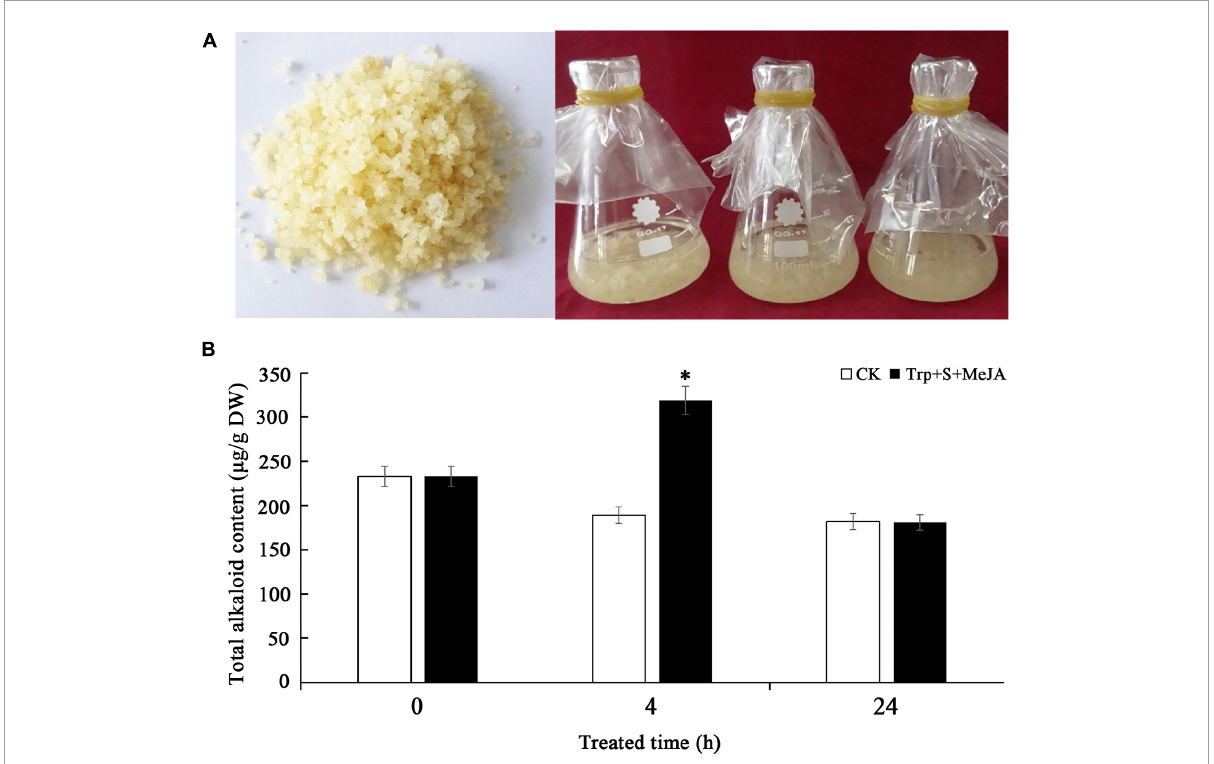
FIGURE1 Determination of total alkaloid content in D. officinale PLBs under Trp + S + MeJA treatment. (A) The PLBs used for Trp + S + MeJA treatment. (B) The total alkaloid content in PLBs treated with TIA precursors and MeJA for 0, 4 and 24 h. Data represent means ± SD from three biological replicates. Asterisks shows significant differences based on the Student’s t -test ( ∗ p <